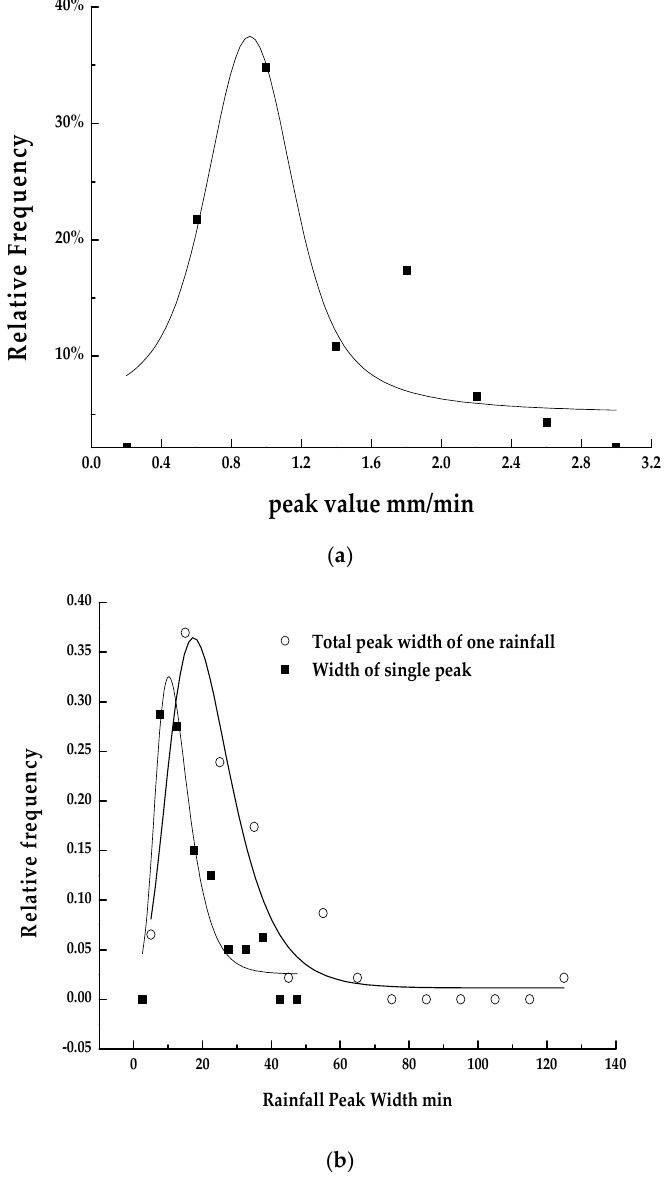
Figure 2. Frequency distribution of rainfall peak and peak width. ( a ) Frequency distribution of rainfall peak value, ( b ) frequency distribution of peak width.